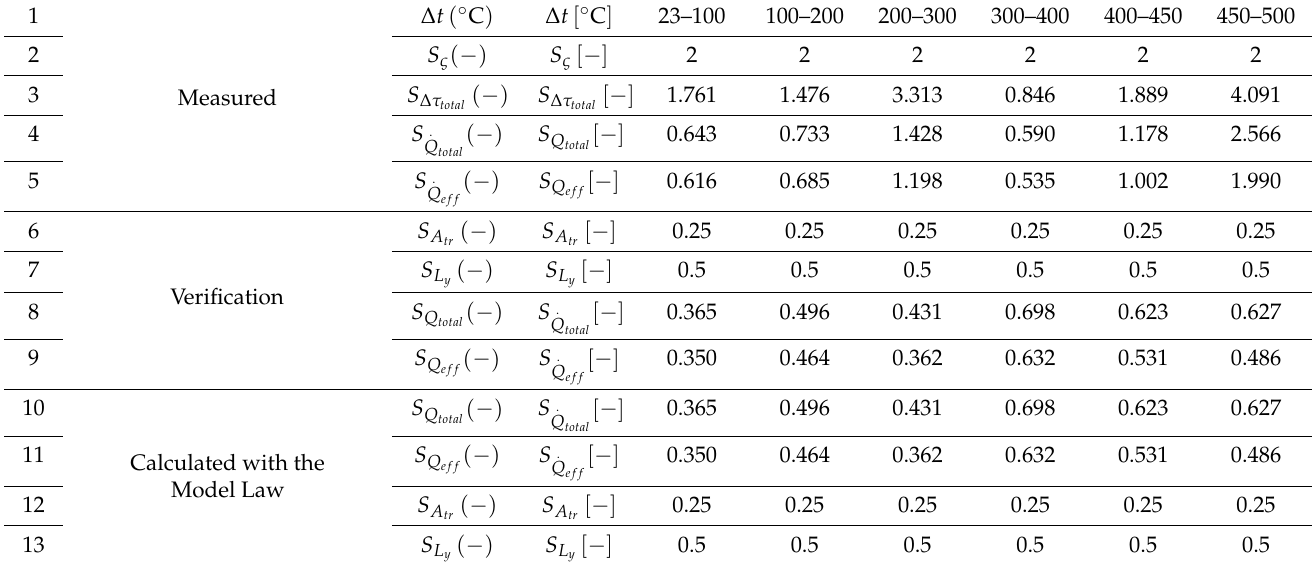
Table A8. The 1:4/1:2 painted model/prototype.